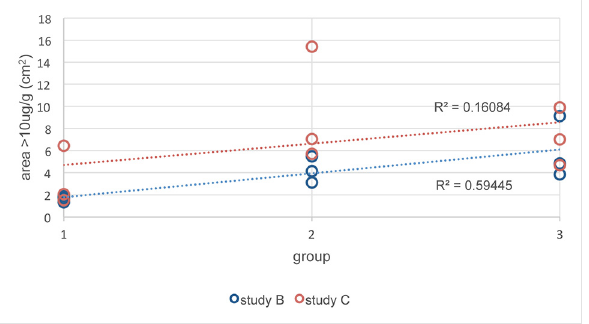
Fig 10. Total areas of the ablation zones with concentrations of doxorubicin above 10 μ g/g. Concentration was determined by fluorescent imaging in groups 1 (single ablation), 2 (3 overlapping ablations) and 3 (6 overlapping ablations) in study B (Covidien device) and C (Angiodynamics